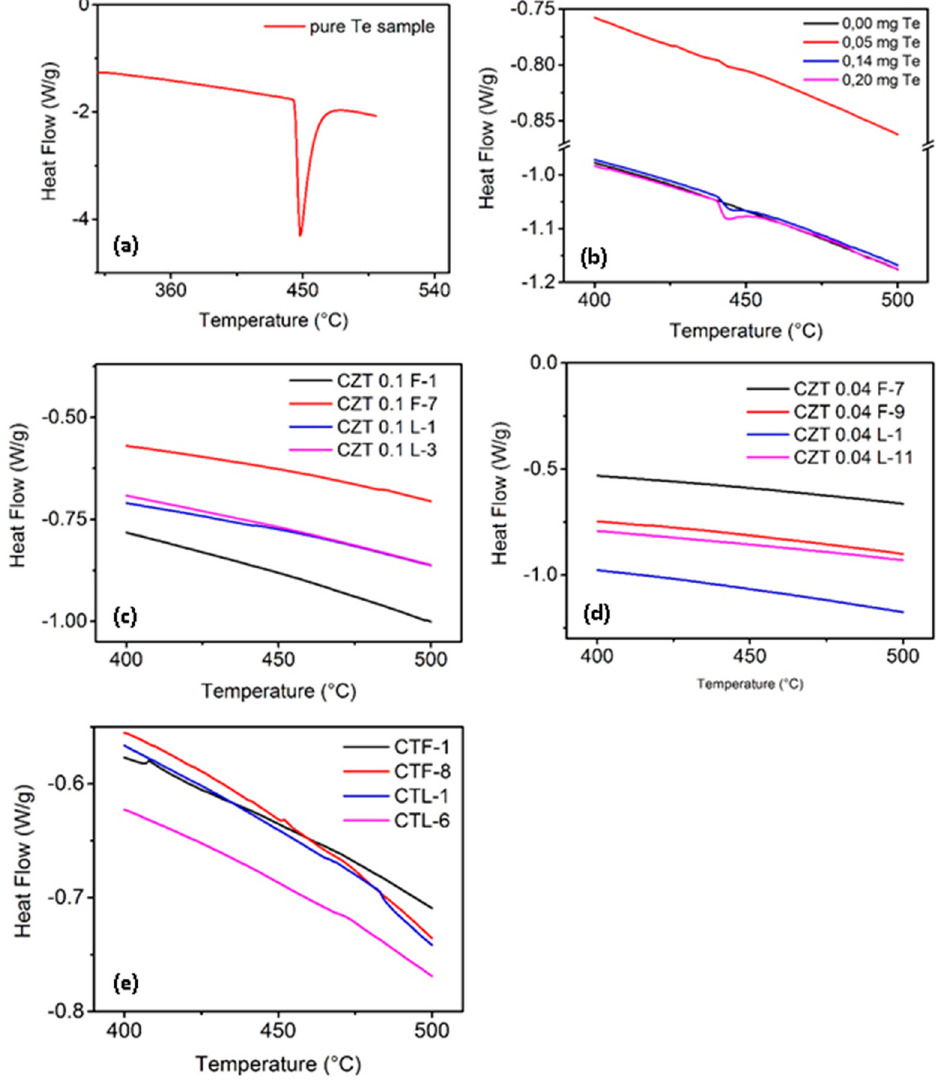
Figure 9. DSC spectra of: ( a ) Pure (s) Te sample; ( b ) Commercial CZT (x = 0.04) with pure (s) Te addition: (1) 0.20 mgTe, (2) 0.14 mgTe, (3) 0.05 mgTe, (4) 0.00 mgTe; ( c ) CZT samples doped with 4 addition; ( c ) CZT samples doped with 10 at% Zn F (1, 7) and L (1, 3); ( d ) CZT samples doped with at% Zn (1, 11) and 10 at% Zn (1, 3), v(L) = 1.66 mm/h; ( d ) CZT samples doped with 4 at% Zn (7, 9) 4 at% Zn F (7, 9) and L (1, 11) and ( e ) CdTe grown at 1.66 mm/h (L-1, L-6) and 3.32 mm/h (F-1, and 10 at% Zn (1, 7), v(F) = 3.22 mm/h; and ( e ) CdTe grown at 1.66 mm/h (L-1, L-6) and 3.32 mm/h (F-1, F-8).